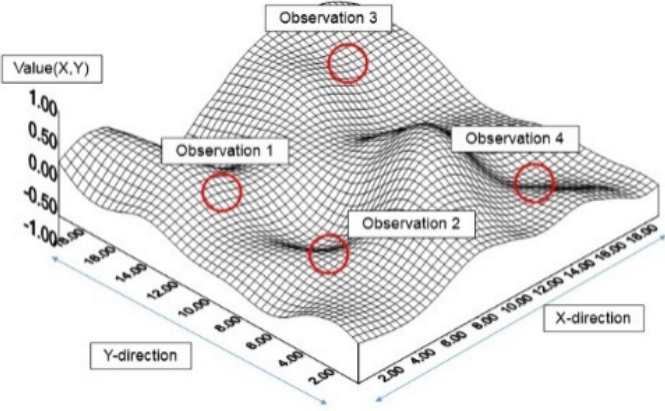
Figure 3. Observation in the stochastic field with spatial randomness.